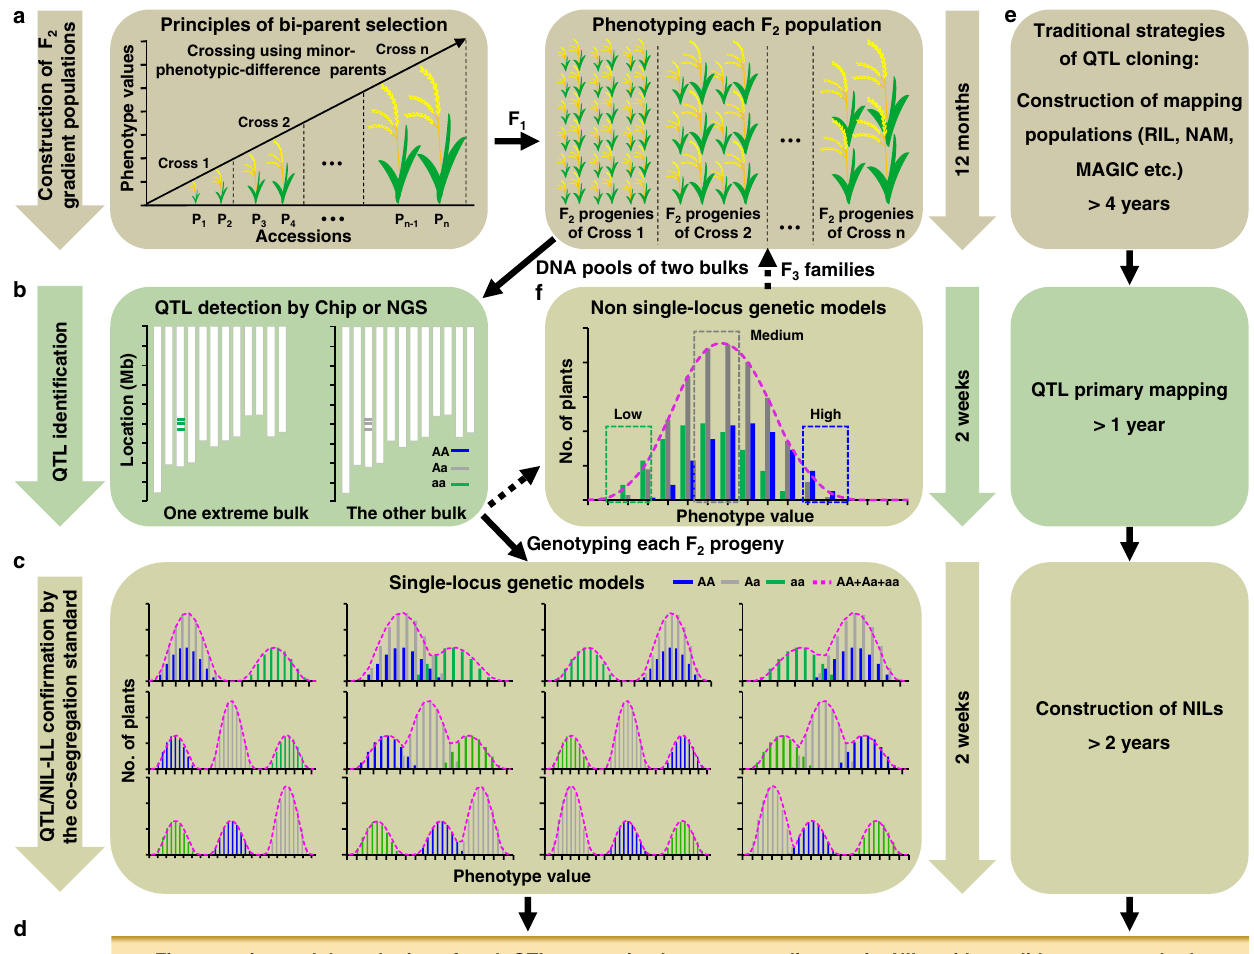
Fig. 1 A simpli fi ed scheme and principle of RapMap. a Construction of F 2 gradient populations using minor-phenotypic-difference parents from diverse germplasms based on the standard described in the text. Each F 2 GP is generated from self-pollinated F 1 plants and phenotypes of F 2 progenies are measured. b Identi fi cation of QTL. Two DNA pools of high-value and low-value bulks are subjected to microarray chip or next-generation sequencing analysis. c The co-segregation standard that the target phenotypes of two homozygous genotypes of a QTL in progenies of any segregating population can be distinguished, is the general principle of the 12 single-locus genetic models as well as the quality-control standard for simultaneous veri fi cation of a real QTL and its NIL-LLs. All the individuals from each F 2 GP are genotyped by the markers fl anking each candidate QTL region and the co-segregation standard is employed to con fi rm each QTL and its NIL-LLs simultaneously. d Fine mapping and cloning of each QTG by screening enough recombinants using the heterozygous plants of NIL-LLs, coupled with various candidate-gene methods. e Traditional processes of QTL cloning that take about eight years and huge efforts. f The genetic population that fails to meet the co-segregation standard could be replaced by a phenotype-well-segregating F 3 or F 4 family derived from a randomly selected low-, medium- or high-value F 2 or F 3 mapping population with single-locus control, we fi rst collected a rice mini-core collection with high genetic diversity across the world, phenotyped them for a target trait, divided the accessions into several gradient groups with similar trait values in each group (with PDI <5%) and the minor phenotypic difference between adjacent groups (with PDI from 8% to 25% or a pro- posed threshold of PDI below 20%), and then selected minor- phenotypic-difference parents (from P 1 to P n ) from each gradient group to make a series of gradient crosses (left panel of Fig. 1a), such as P 1 with P 2 , P 2 with P 3 , P 3 with P 4 . The subsequent F 2 populations derived from these gradient crosses using minor- phenotypic-difference parents are de fi ned as F 2 gradient popu-